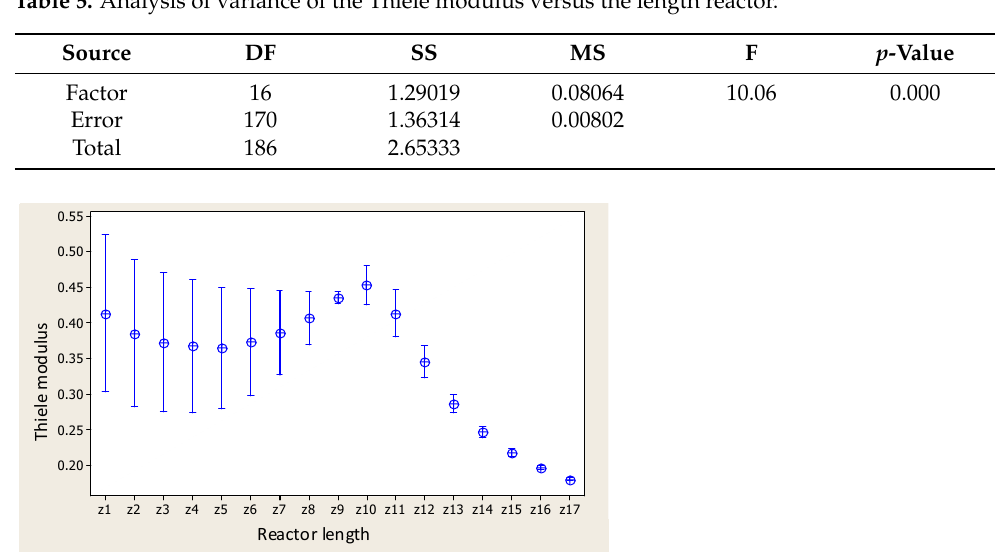
Table 5. Analysis of variance of the Thiele modulus versus the length reactor.